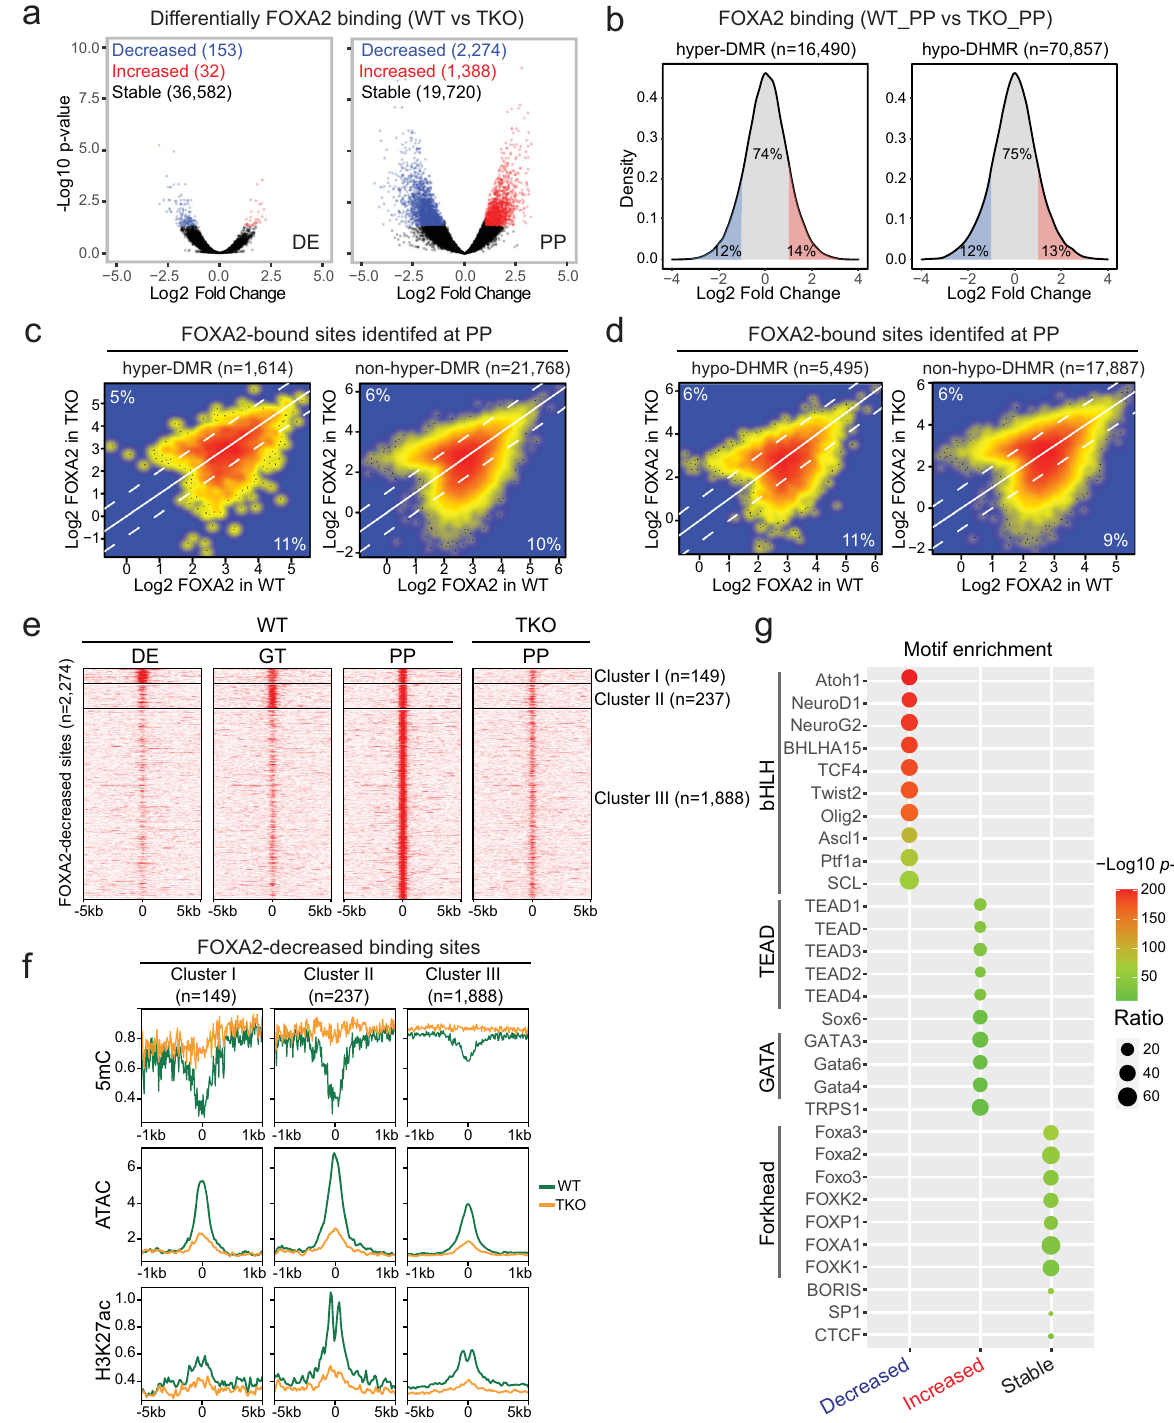
FOXA2 from DE-to-PP stage, cluster II regions (237) were FOXA2-bound at GT and PP stages, while the most predominant group, cluster III (1888), displayed de novo FOXA2 occupancy in pancreatic progenitors (Fig. 4e). We then analyzed the annota- tions of nearby genes with Genomic Regions Enrichment of Annotations Tool (GREAT) and found that cluster III regions were enriched in terms of neuron and endocrine pancreas development (Supplementary Fig. 4e). Further examination of ATAC-seq, H3K27ac, and 5mC signals in three